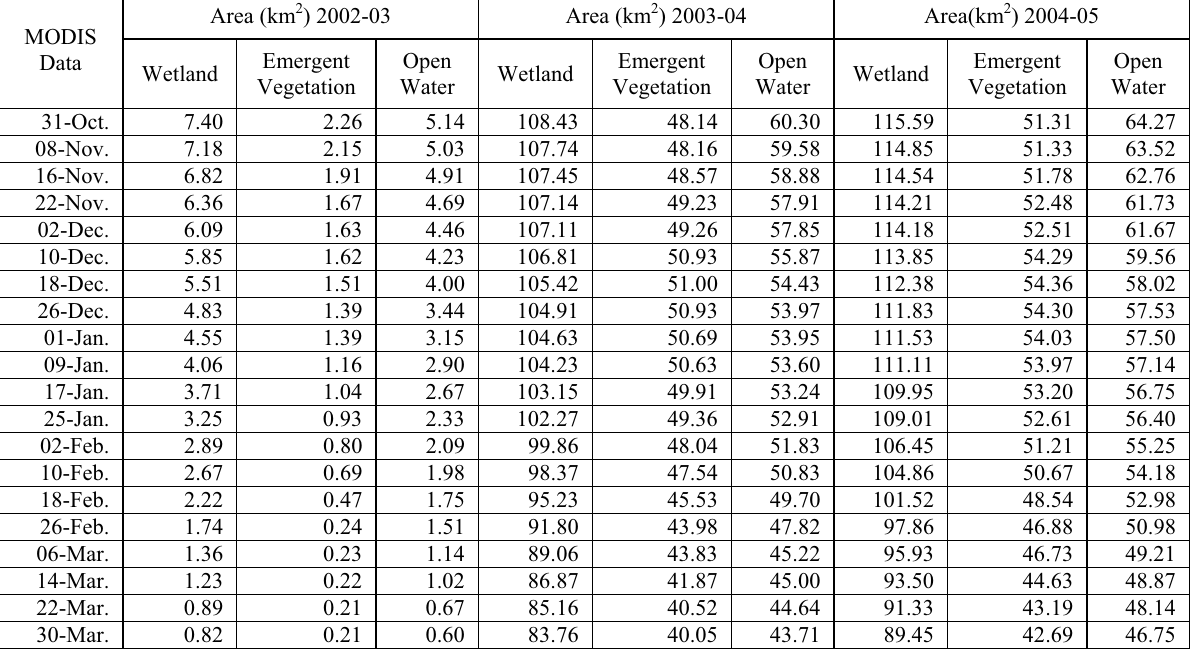
Table-1. Seasonal changes in the extent of open-water and emergent vegetation (from October to March) derived from MODIS 8 day composite data for